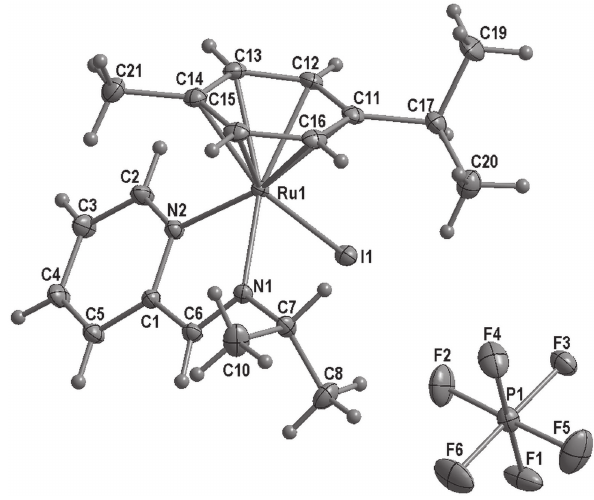
figure. Table 1 contains crystallographic data and Table 2 con- tains the list of the atoms including atomic coordinates and displacement parameters.